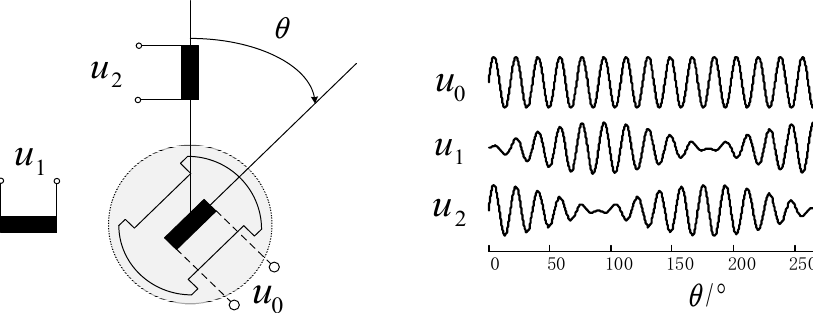
Figure 1. Schematic diagram of resolver structure and voltage waveform.